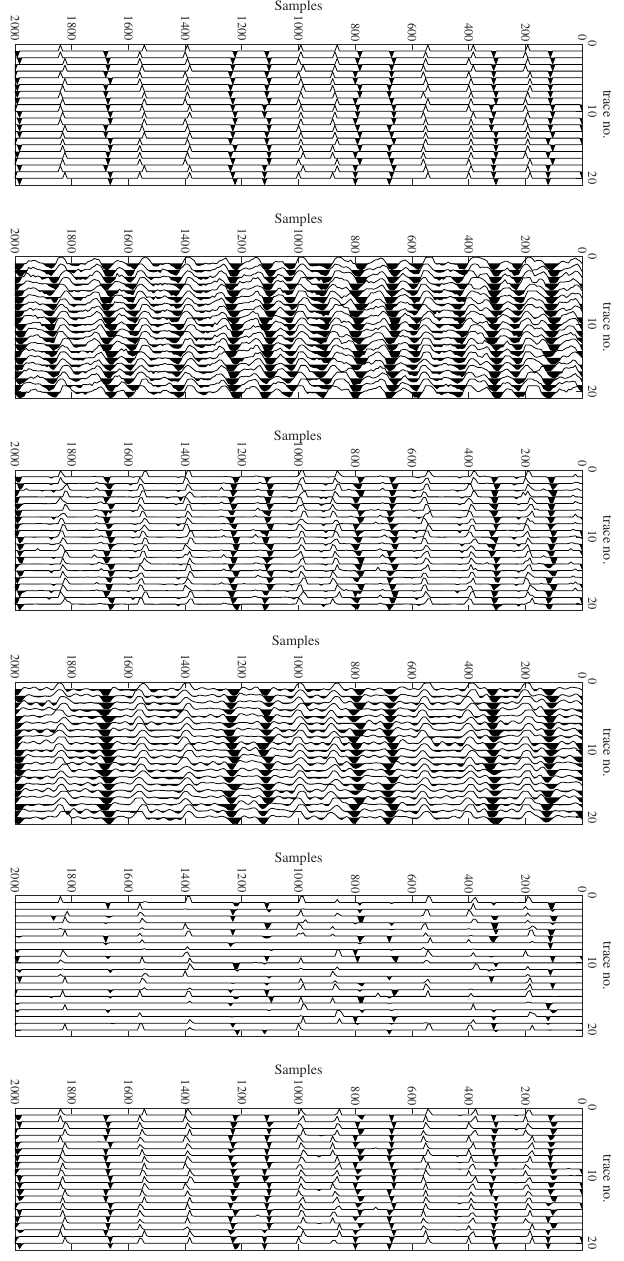
Figure 4. Deconvolution result for Q = 0.8 Y. Top to bottom: True reflectivity, received data with SNR = 10dB, BP method, SD method, proposed method (initial), proposed method (refined). For the SD method, a deconvolution filter of length 51 is used. The filter is initialized with a solitary spike that is located approximately in the middle of the filter used for deconvolution. Other parameters used in the experiments are given as follows: α = 0.2, (cid:101) f = 1, step size µ = 0.02, the stopping criterion is marked as 1000 iterations, the hybrid norm parameter (cid:101) k is set to 0.005, and the regularization parameter λ is fixed to 2. The SD method’s iteration count is set to 800 to ensure that the algorithm reaches a